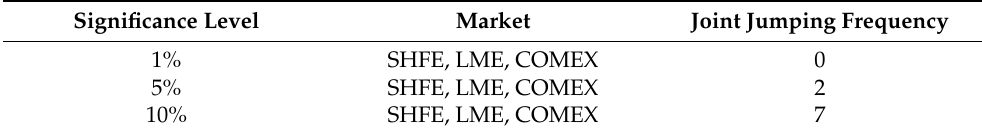
Table 17. Joint jumps between the three